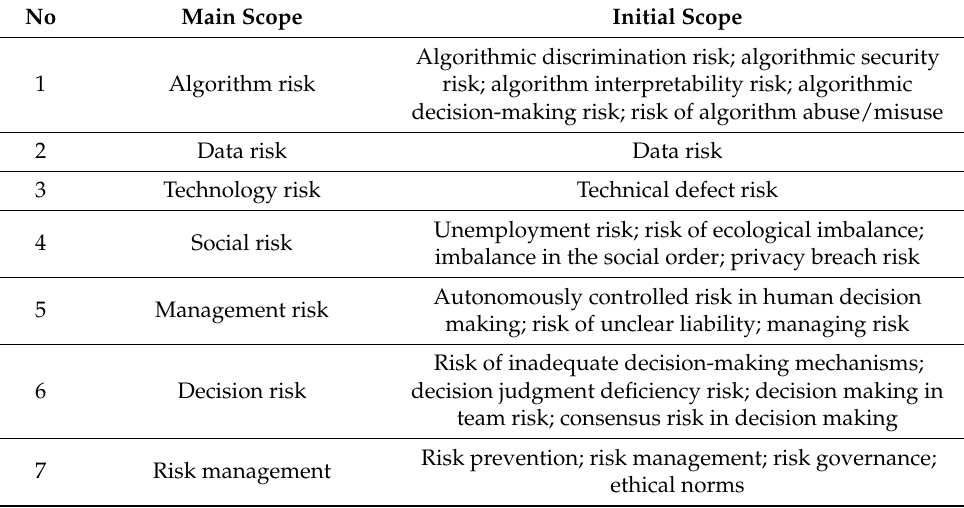
Table 2. Spindle code and main scope.